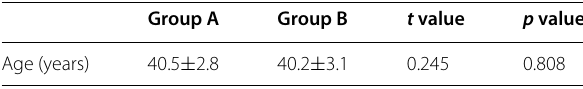
Table 2 Age of subjects in both groups